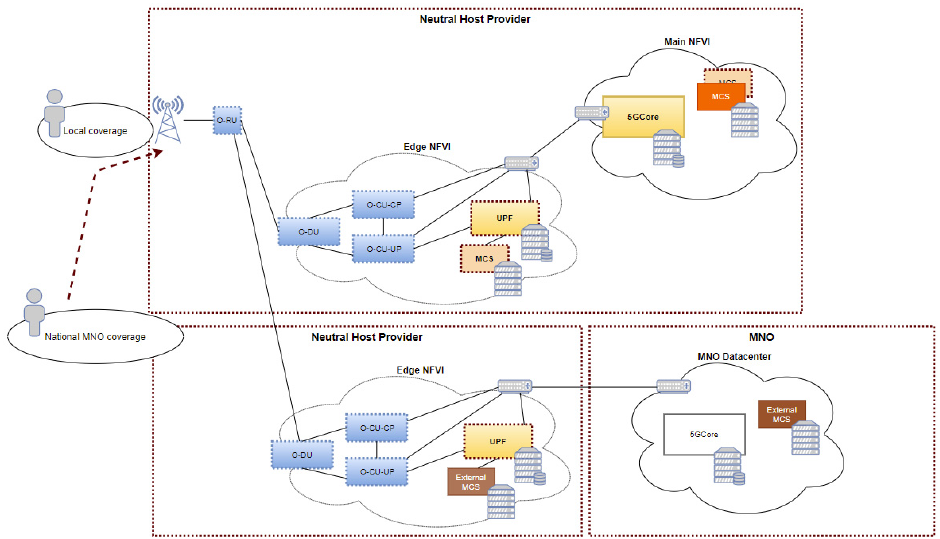
Figure 8. Second deployment scenario of the emergency communication critical system.